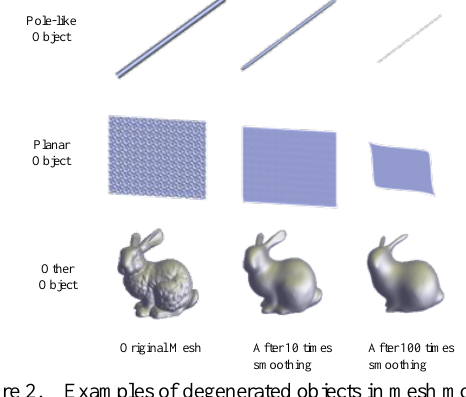
Figure 2. Examples of degenerated objects in mesh model by